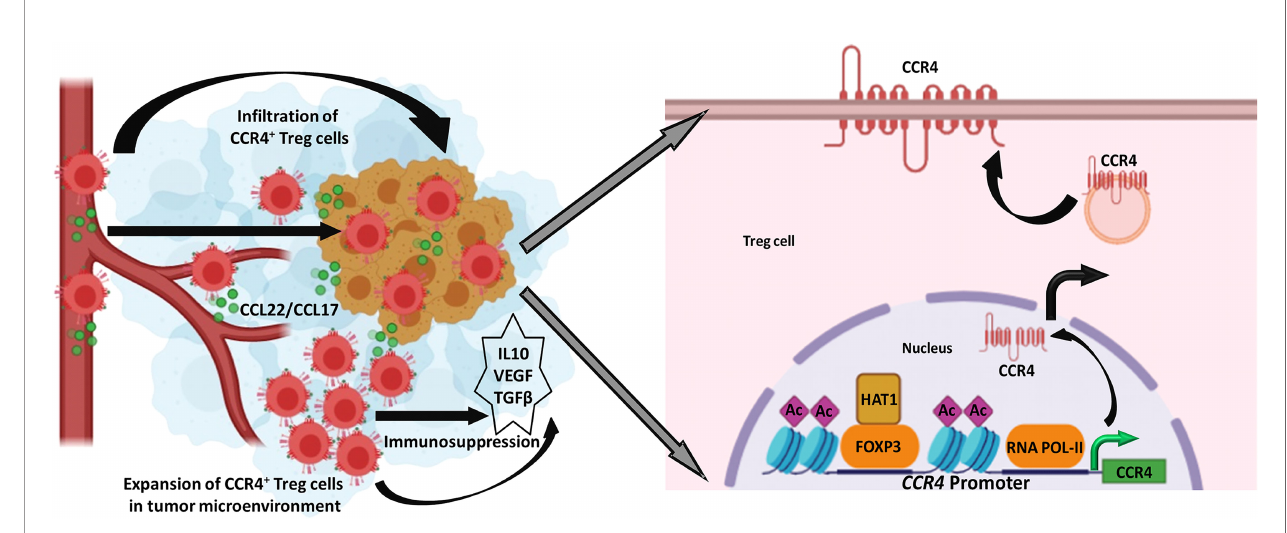
FIGURE 7 | FOXP3-transcribed CCR4 expression regulates Treg in fi ltration in tumor site. Left: CCR4 + Tregs are in fi ltrated in the tumor microenvironment in response to tumor-secreted CCL22/CCL17 to promote tumor immune escape. Right: FOXP3 in the association of HAT1 binds to CCR4 promoter to epigenetically modify it for optimal transcription of CCR4